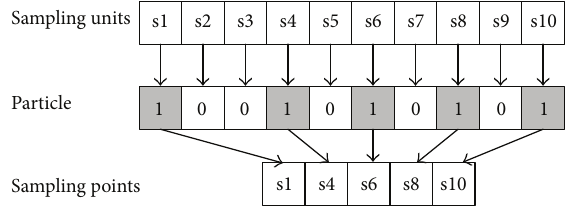
Figure 3: Mapping relationship between the units, a binary particle, and a monitoring network. Example illustrates that a particle consists of 10 cells and contains 5 monitoring